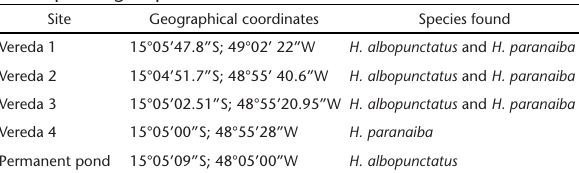
Table 1. Geographical location and species of the Hypsiboas albopunc- tatus species group found in each